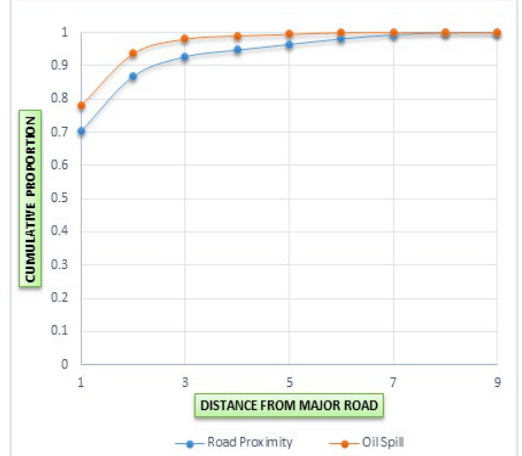
Figure 11. Proximity of roads to spills locations